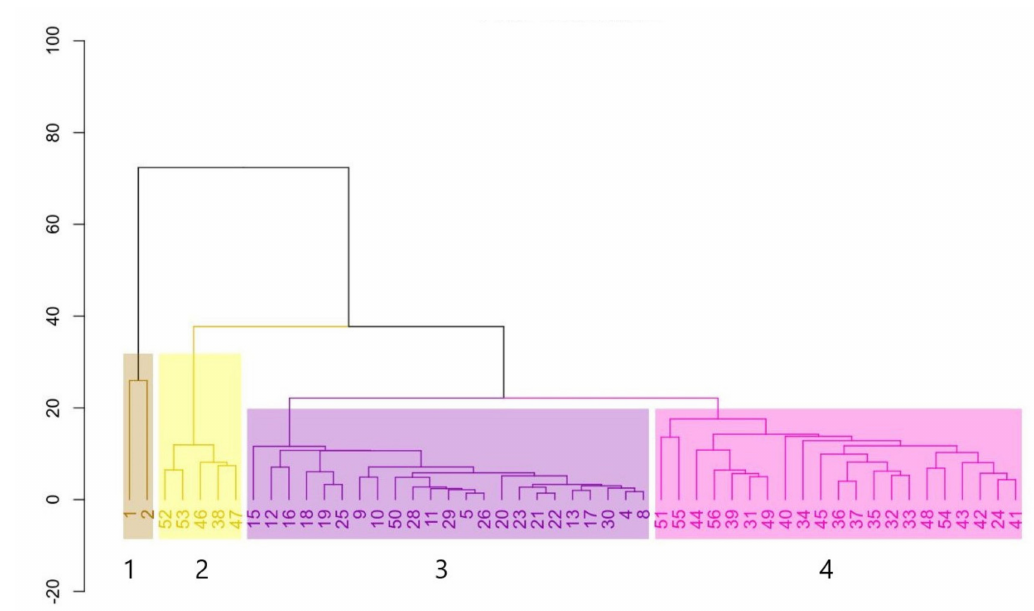
Figure 2. Cluster analysis based on species abundance data, in 51 0.1-hectare plots on the banks of the Acom é River, using Euclidean distance and Ward’s method. Plots are grouped on the horizontal axis, while the vertical axis indicates the degree of proportional similarity between the species within the plots. Clusters are numbered 1 to 4.